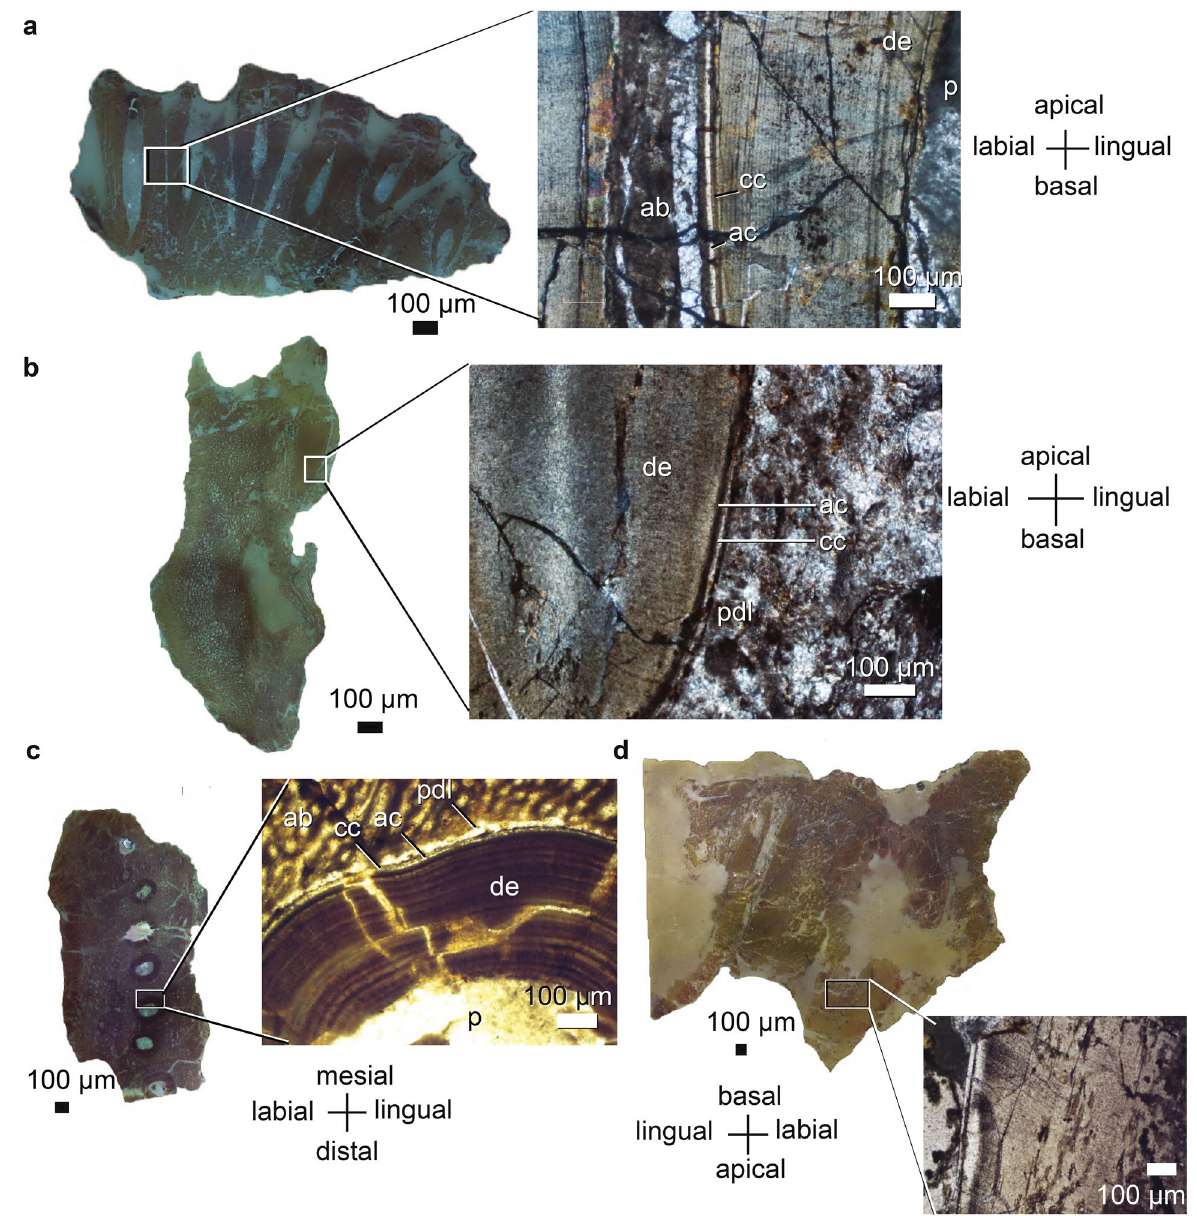
Figure 3. Maxillary histological sections of Endothiodon tolani specimens from the K5 Formation, Metangula Graben, Mozambique. ( a ) Sagittal section of the PPN2014-11 maxilla. ( b ) Coronal section of the PPN2014-15 maxilla. ( c ) Horizontal section of the PPN2014-11 maxilla. ( d ) Coronal section of the PPN2014-15 maxilla. ab alveolar bone, ac acellular cementum, cc cellular cementum, de dentine, p pulp cavity, pdl periodontal ligament